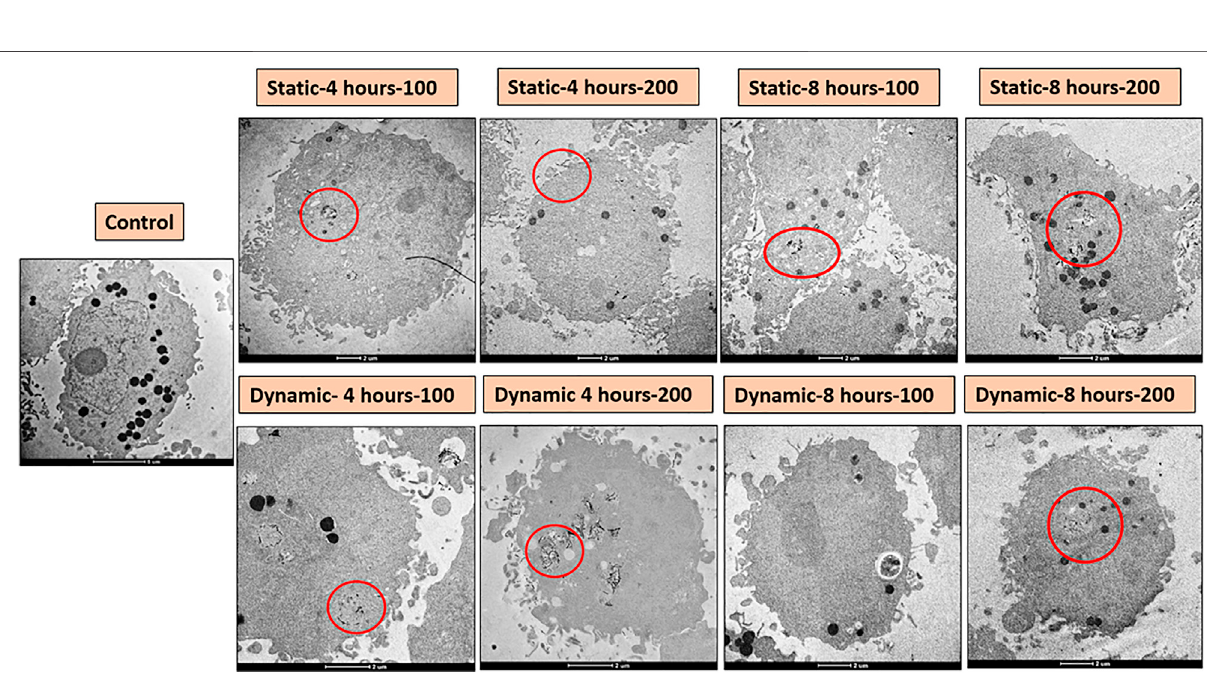
FIGURE 5 | TEM images for MDA-231 cells treated with MXene under different conditions. MXene 2D sheets are indicated by the red